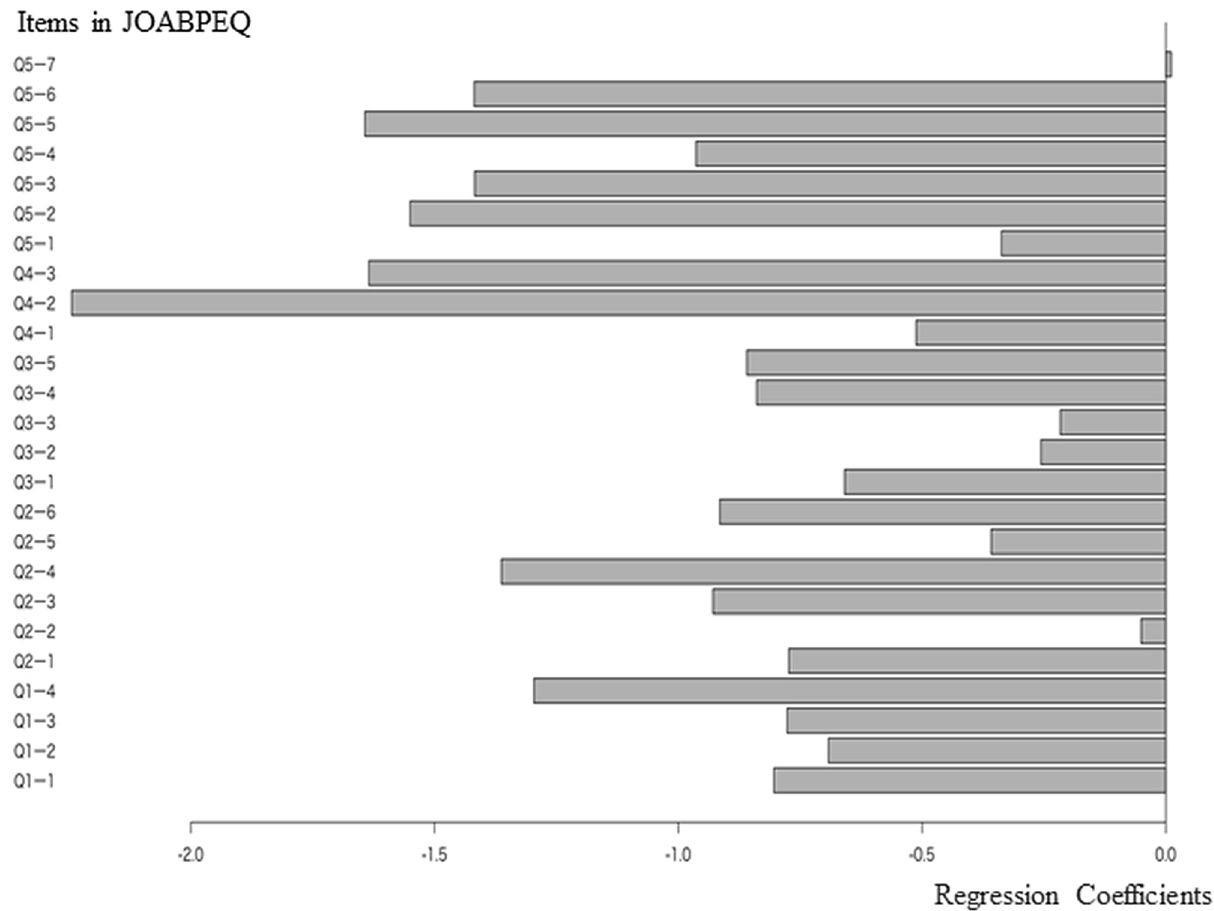
Fig 3. Regression coefficients of each JOABPEQ item for the degree of lower limb